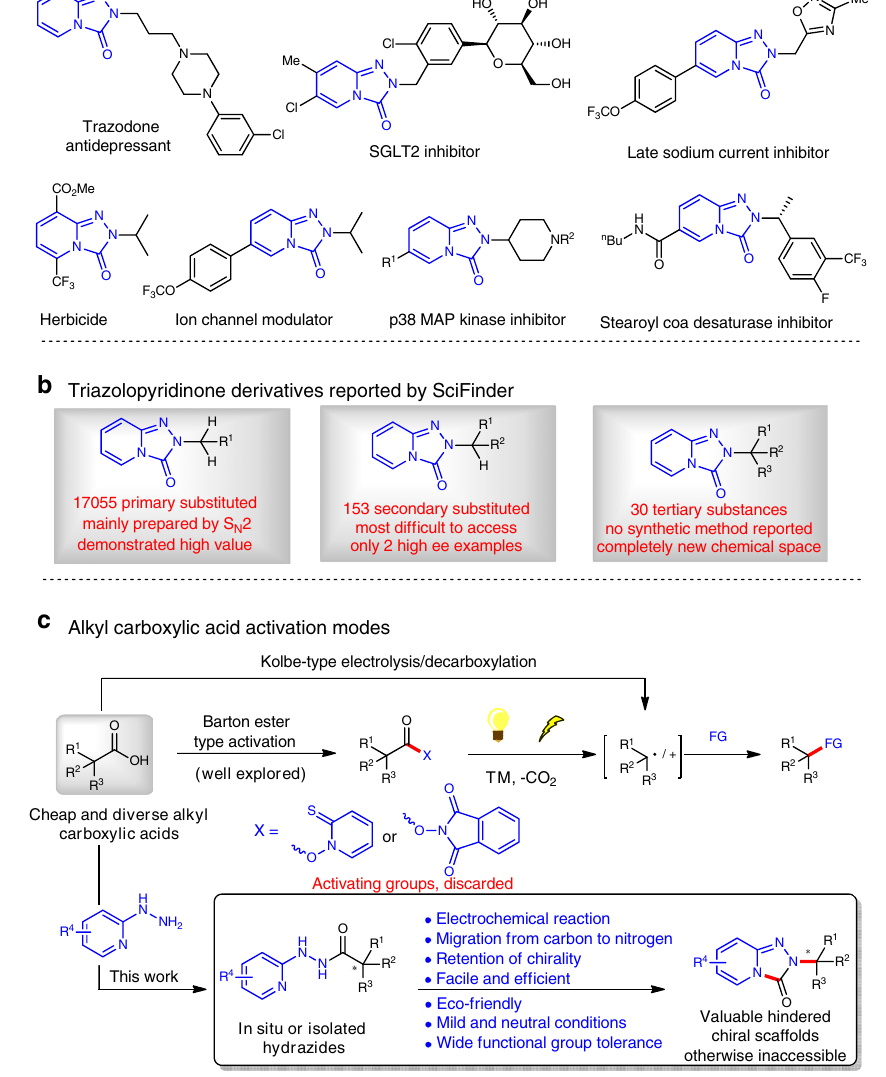
Fig. 1 Background and reaction development. a Representative bioactive molecules with triazolopyridinone scaffold. b Triazolopyridinone derivatives reported by SciFinder. c Alkyl carboxylic acid activation modes. TM transition metal, FG functional